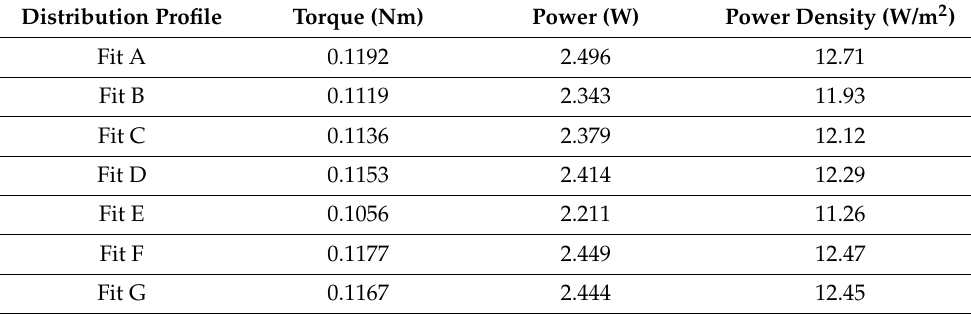
Table 8. Power generation for the studied twist distributions.